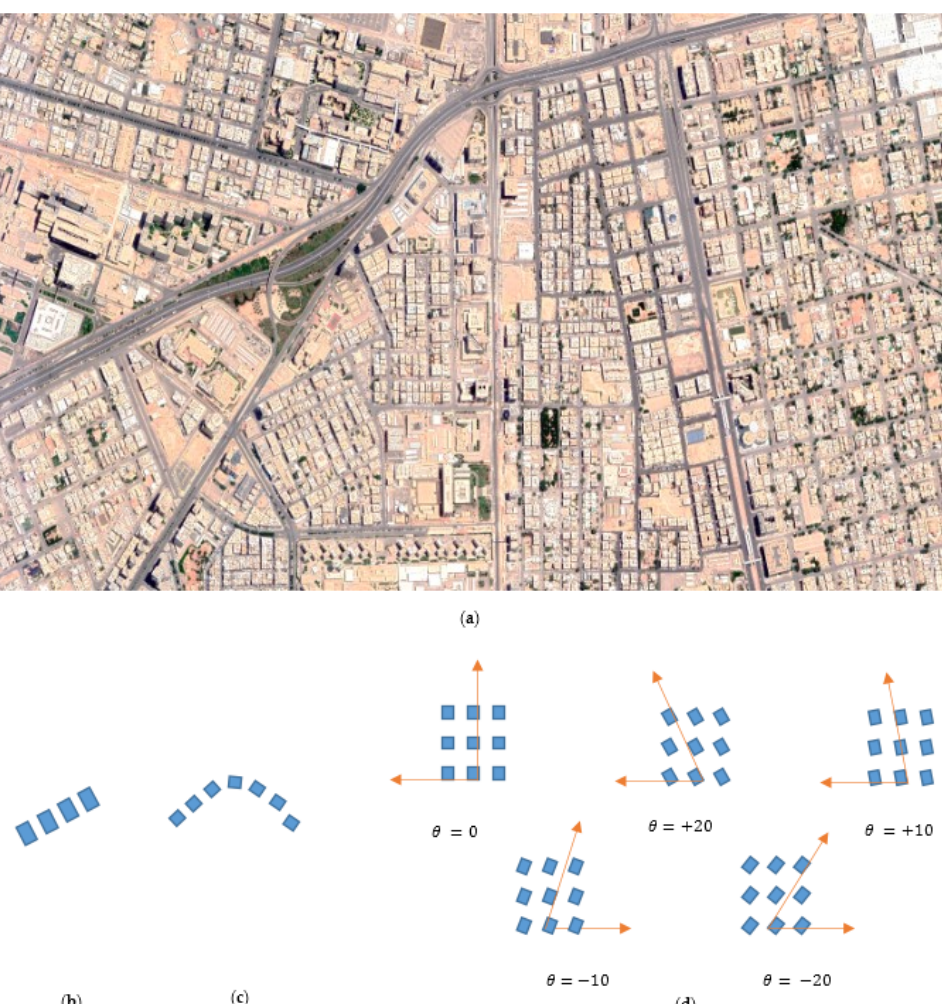
Figure 1. ( a ) High-resolution satellite image shows different building orientation angles in dense building view in Riyadh city, ( b ) linear building alignment representation, ( c ) curvilinear building alignment representation, and ( d ) grid building alignment representation with different orientation